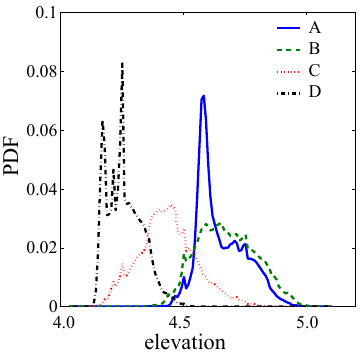
Figure 3. Elevation distributions of the DEM for sites A, B, C and